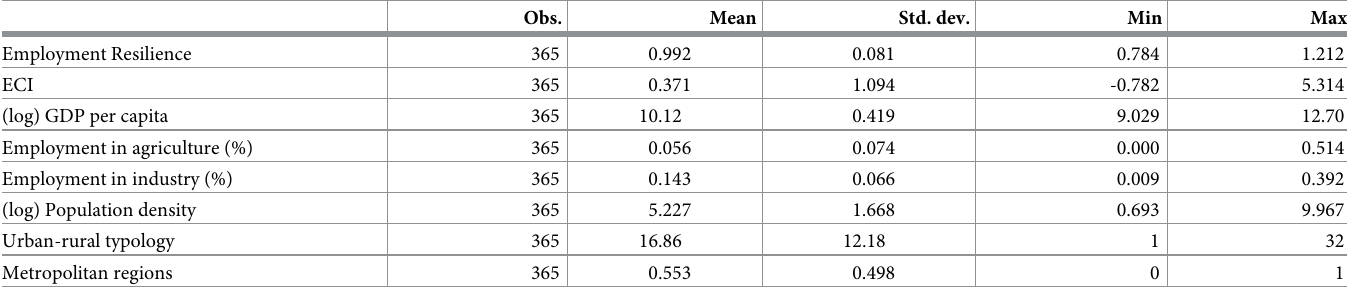
Table 2. Summary statistics.